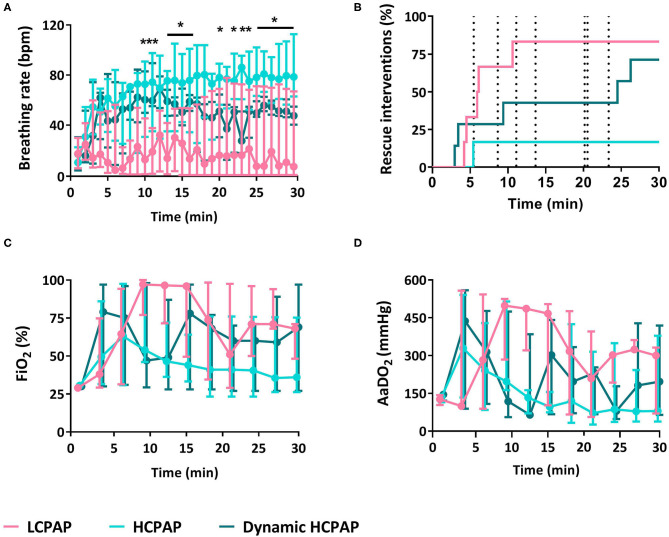
Breathing and support. Median (Q1–Q3) breathing rate (A), rescue interventions (B), fraction of inspired oxygen (FiO2, C), and alveolar to arterial differences in PO2 (AaDO2, D) in lambs receiving LCPAP vs. HCPAP vs. dynamic HCPAP in the first 30 min after birth (time 0 = cord clamping). All parameters were compared over time using linear mixed-effect regression models. One (*) or two asterisks (**) indicate significant difference between the LCPAP vs. (dynamic) HCPAP or LCPAP vs. both HCPAP groups, respectively. Dotted vertical lines (B) indicates the point of CPAP change in the dynamic HCPAP group.